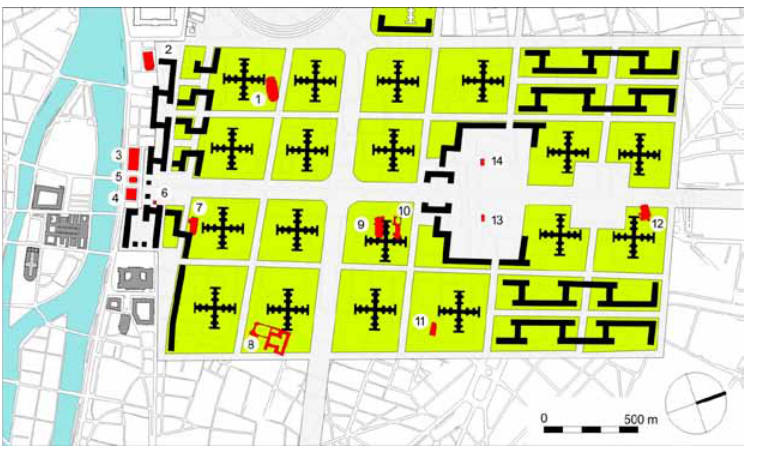
fig. 14. Sector a (Business Center)